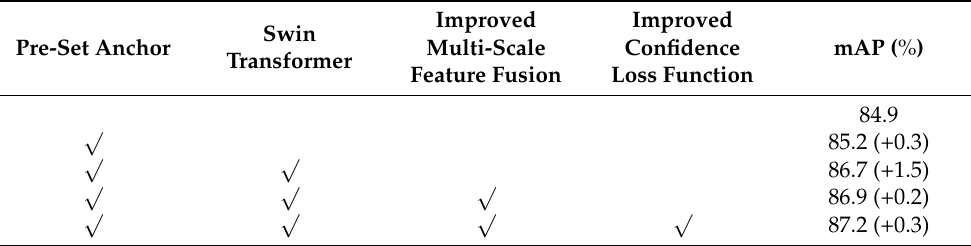
Table 4. Ablation experiments.